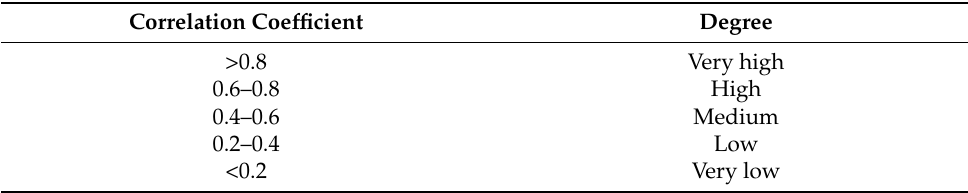
Table 3. Pearson correlation. Correlation